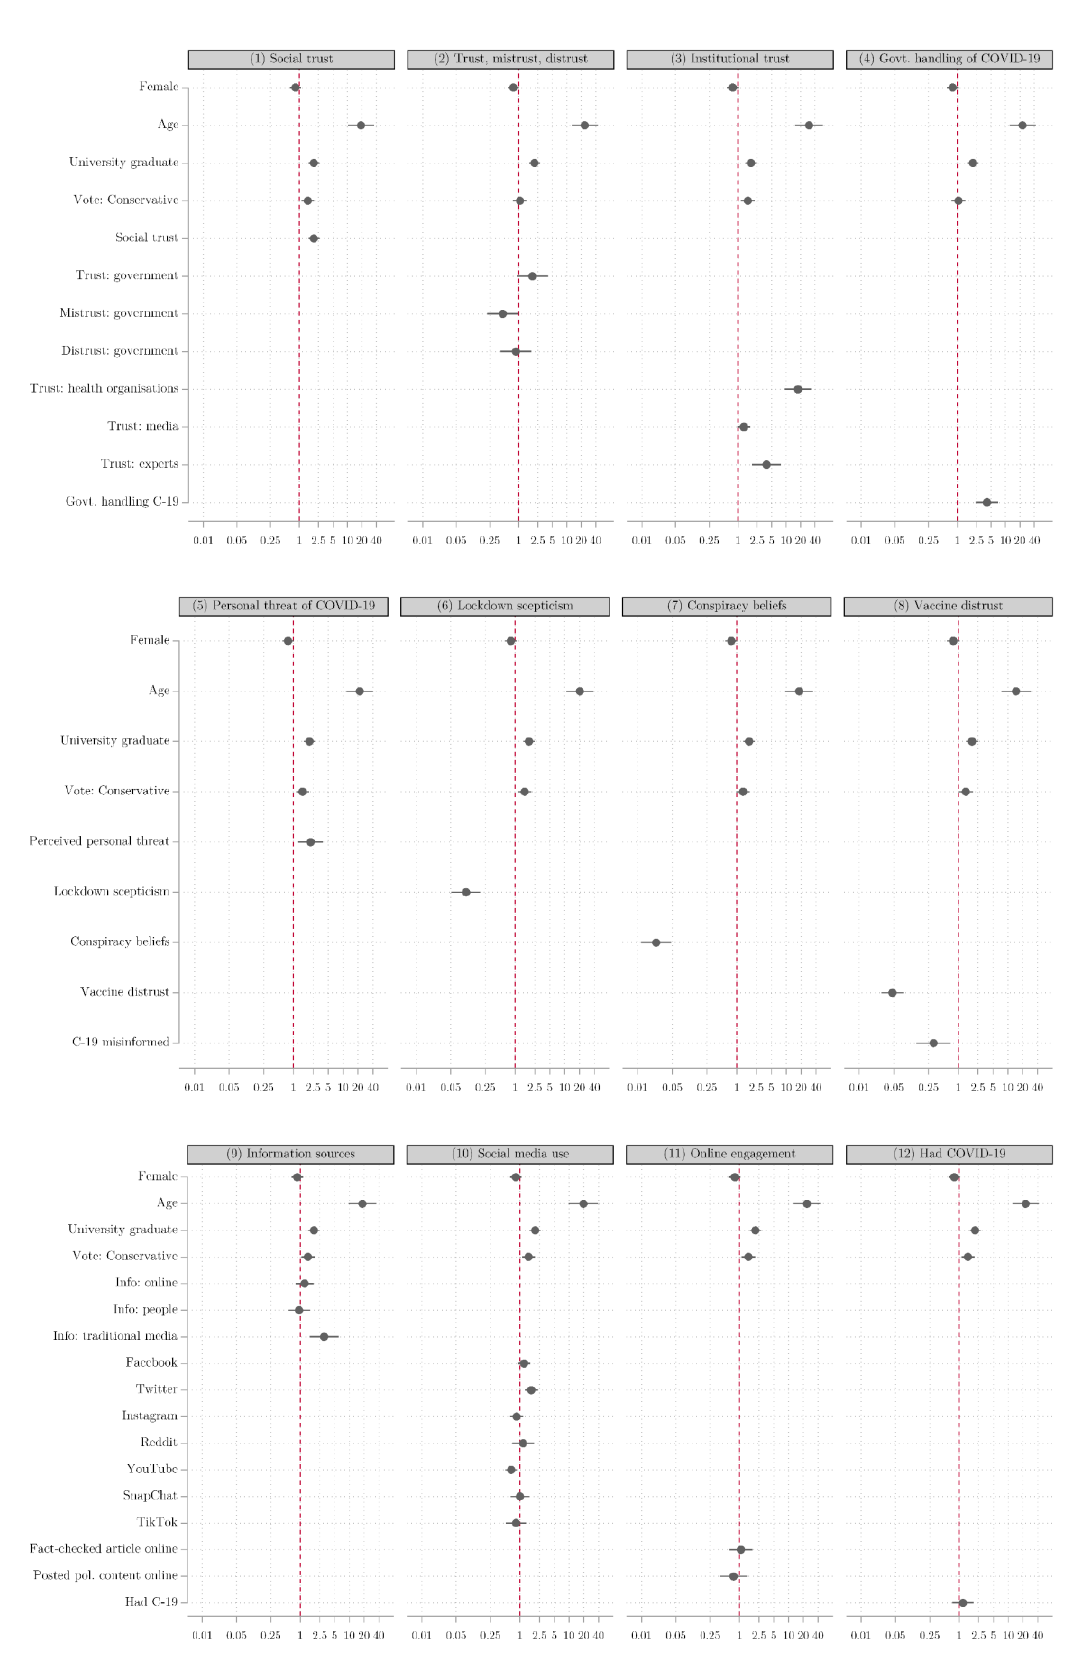
Figure 2. Multivariate logistic regression of vaccine willingness, odds ratios.